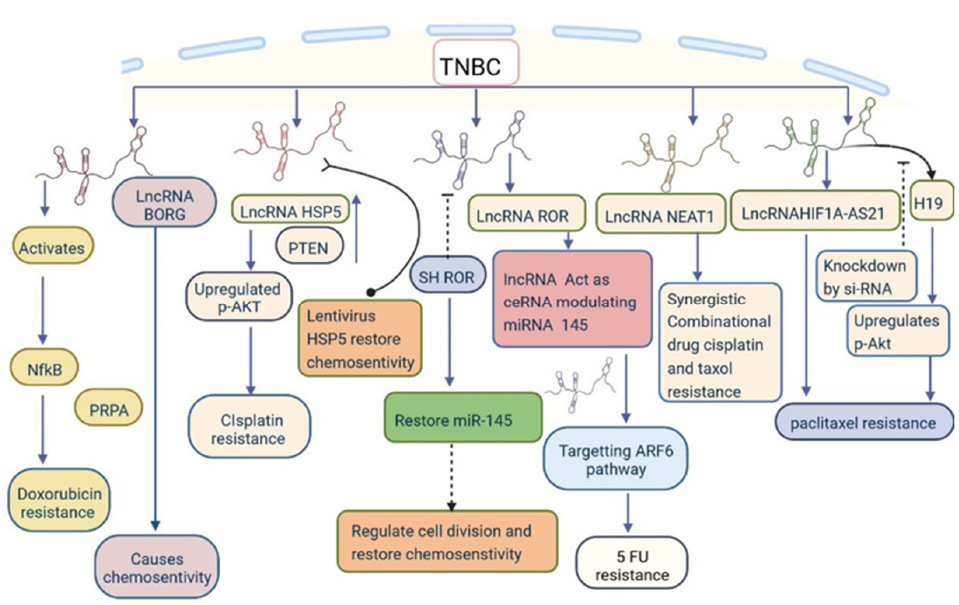
Figure 8. lncRNAs are involved in drug resistance through various mechanisms. Table 2. lncRNAs participate in the drug resistance of TNBC